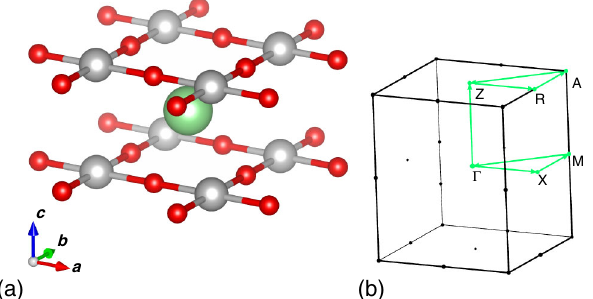
FIG. 1. Infinite-layer NdNiO 2 . (a) Crystal structure with Nd (green), Ni (blue), and O (red) sites. (b) Brillouin zone with high- 0 and k 1 = 2 plane. Green lines symmetry points in the k z ¼ z ¼ depict the path for plots of the spectral function A ð k ; ω Þ